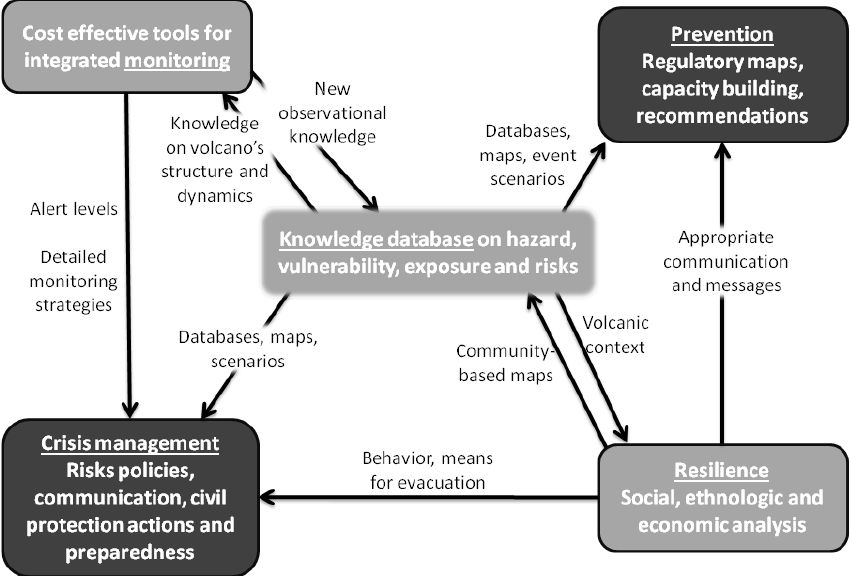
18 Figure 1. Conceptual frame of the various elements for integrated risk management (black boxes: institutional and operational actions; grey boxes: scientific and technical tools, arrows: information